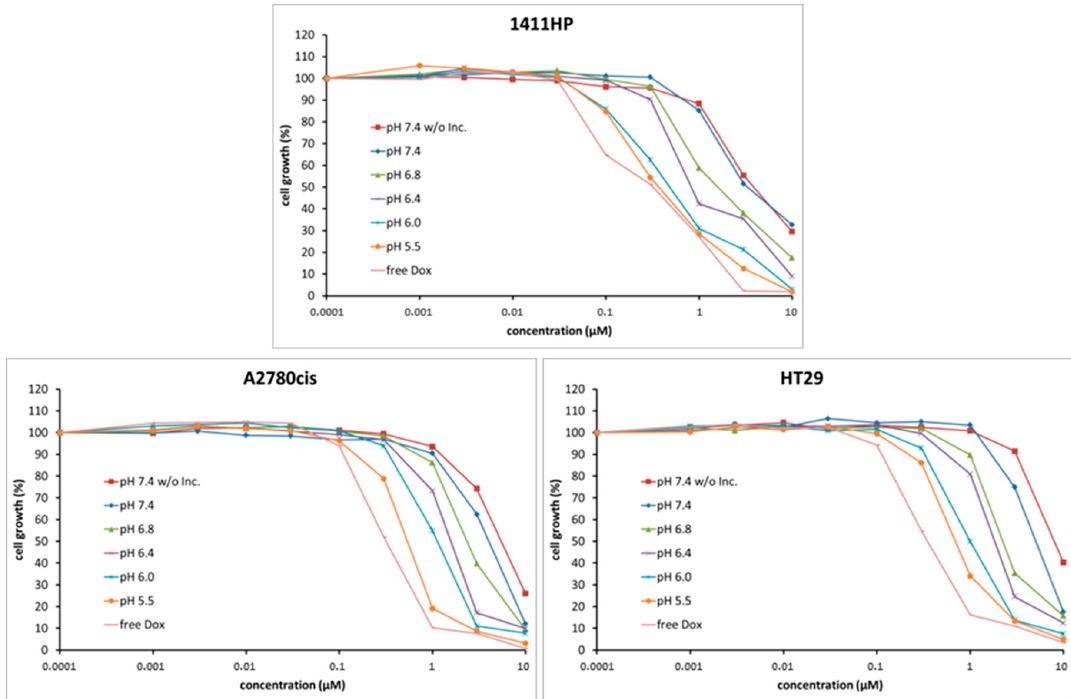
Figure 3. Analysis of pH-dependent drug release and activation of pHPMA-Dox-Cy7. The conjugate was pre-incubated in buffers with different pH values for 24 h and immediately used for the assay. The cell lines were treated for 2 h and analyzed after further incubation for 96 h in drug-free medium.